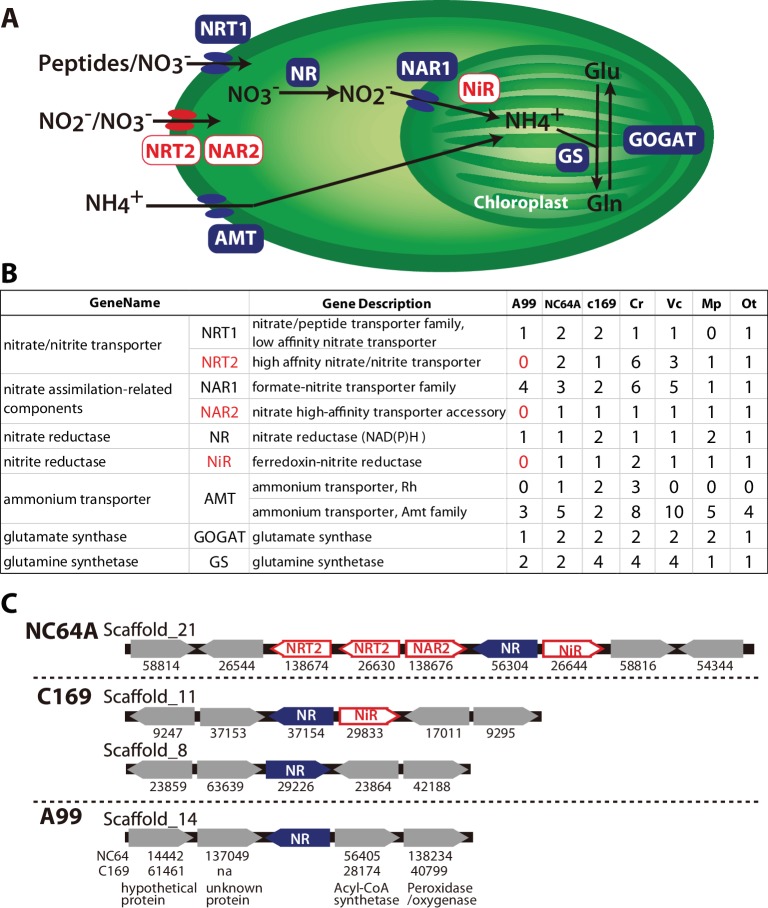
Nitrogen assimilation pathways in Chlorella A99.(A) Schematic diagram of the nitrogen assimilation pathway in plants showing the function of nitrate transporters NRT1 (peptides/nitrate transporter) and NRT2 (nitrate/nitrite transporter), nitrate assimilation-related components NAR1 and NAR2, nitrate reductase NR, nitrite reductase NiR, ammonium transporter AMT, glutamate synthetase GOGAT and glutamine synthetase GS. Genes shown in red boxes (NRT2, NAR2 and NiR) were not found in the Chlorella sp. A99 genome. (B) Table showing the number of nitrogen assimilation genes in Chlorella sp. A99 (A99), Chlorella variabilis NC64A (NC64A), Coccomyxa subellipsoidea C169 (C169), Volvox carteri f. nagariensis (Vc), Chlamydomonas reinhardtii (Cr), Ostreococcus tauri (Ot) and Micromonas pusilla (Mp). (C) Gene clusters of nitrate assimilation genes around the shared NR genes (blue) in the genomes of NC64A, C169 and A99. Red boxes show nitrate assimilation genes absent in A99 and gray boxes depict other genes. Numbers below the boxes are JGI protein IDs of NC64A and C169. Numbers below the genes of A99 are JGI protein IDs of the best hit genes in NC64A and C169 and their gene name.